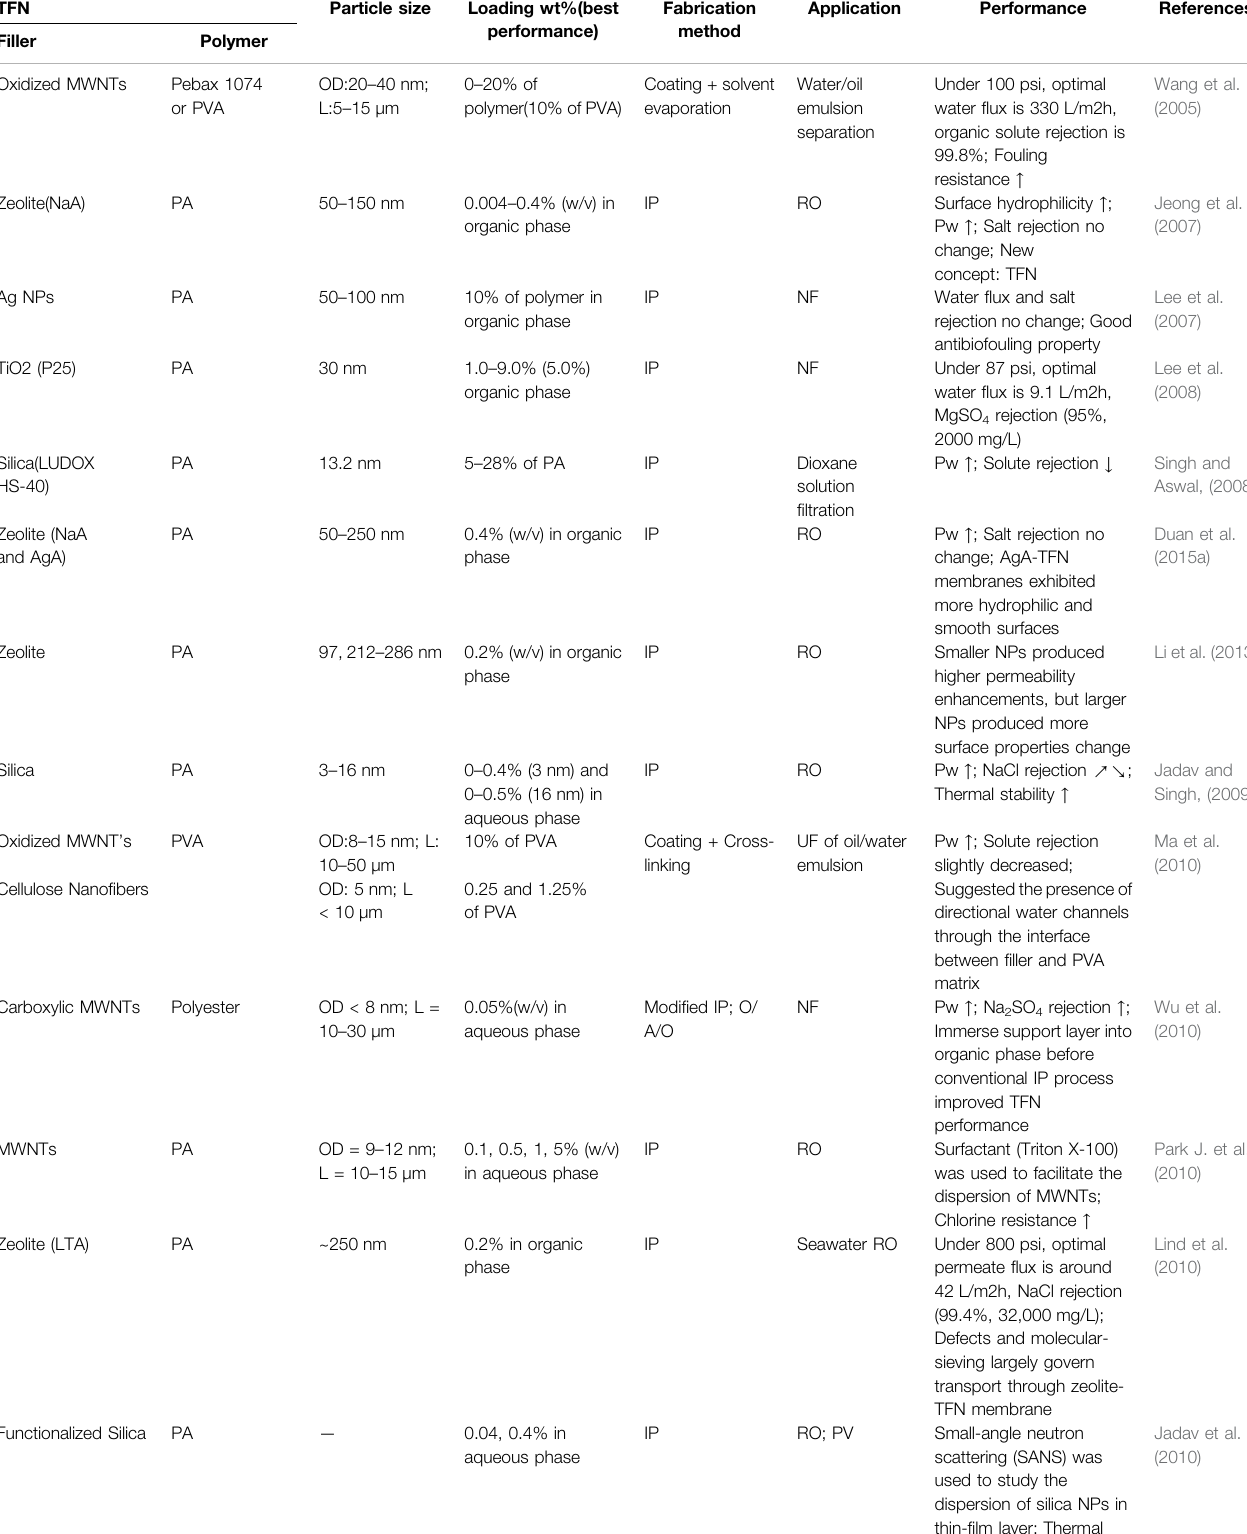
TABLE 4 | Summary of TFNs and their composition, performance, fabrication and